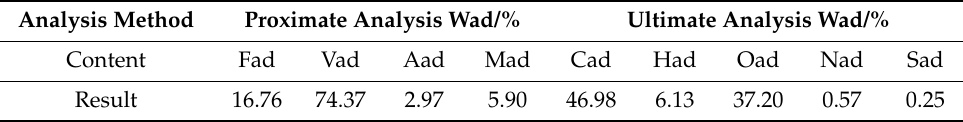
Table 1. Proximate and ultimate analyses of maize